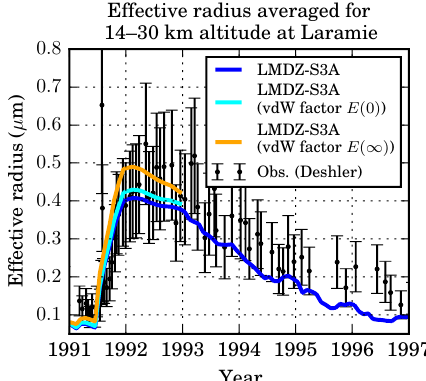
Figure 13. Evolution of the global mean stratospheric aerosol opti- cal depth (SAOD) at 550nm modelled with LMDZ-S3A compared to the climatology from Sato (2012) and to SAOD simulated with WACCM by Mills et al. (2016). The dashed (dotted) line shows the model result for coagulation enhanced by the continuum regime van der Waals enhancement factor E( 0 ) (the kinetic regime enhance- ment factor E( ∞ ) ).